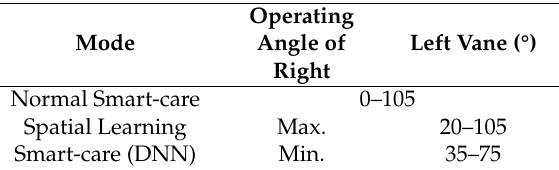
Table 3. Experiment mode—Smart-care.